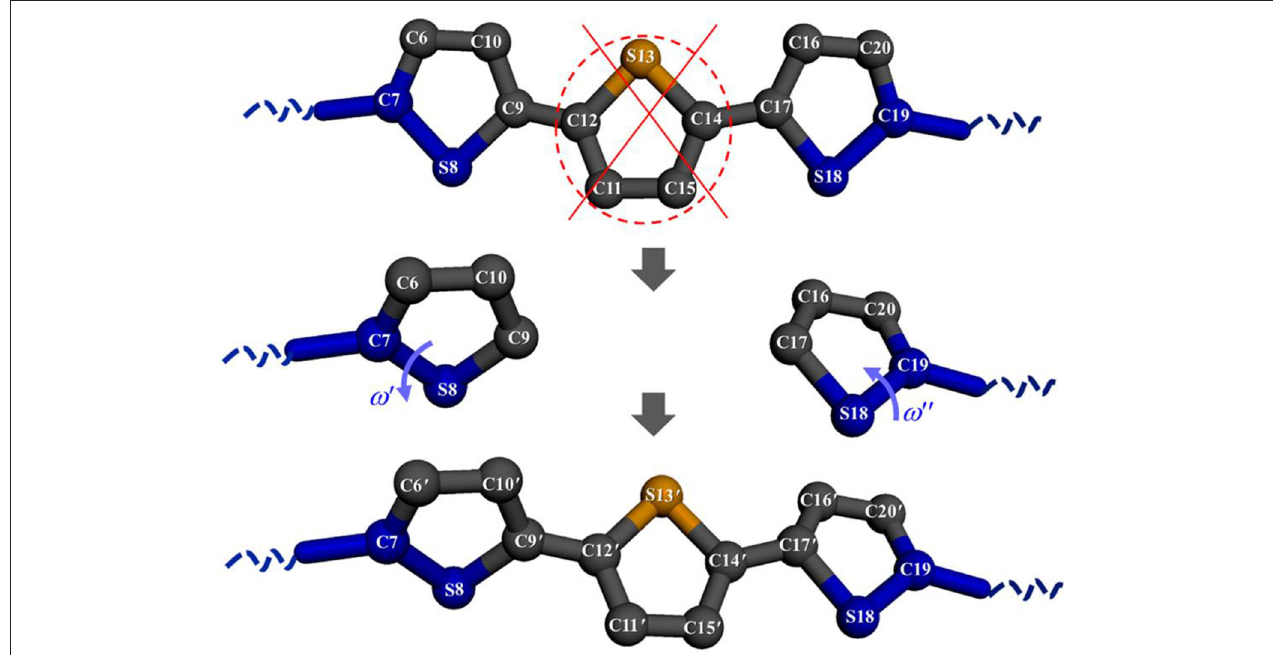
FIGURE 6 | Schematic illustration of the ring ConRot move. Reprinted (adapted) with permission from Tsourtou et al. [56]. Copyright (2018) American Chemical Society.